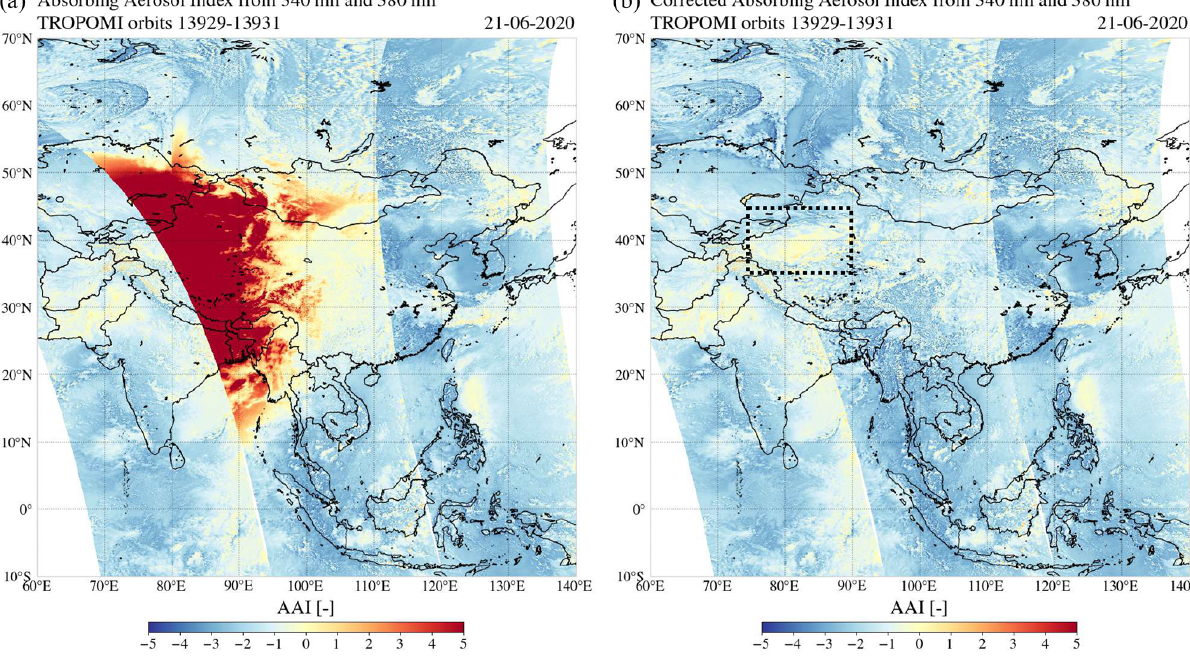
Figure 20. The absorbing aerosol index from the 340 and 380nm wavelength pair by TROPOMI on 21 June 2020 over Asia in orbits 13929–13931, uncorrected (a) and after the solar irradiance correction (b) . In the corrected image, the Taklamakan Desert is located in the rectangular dotted